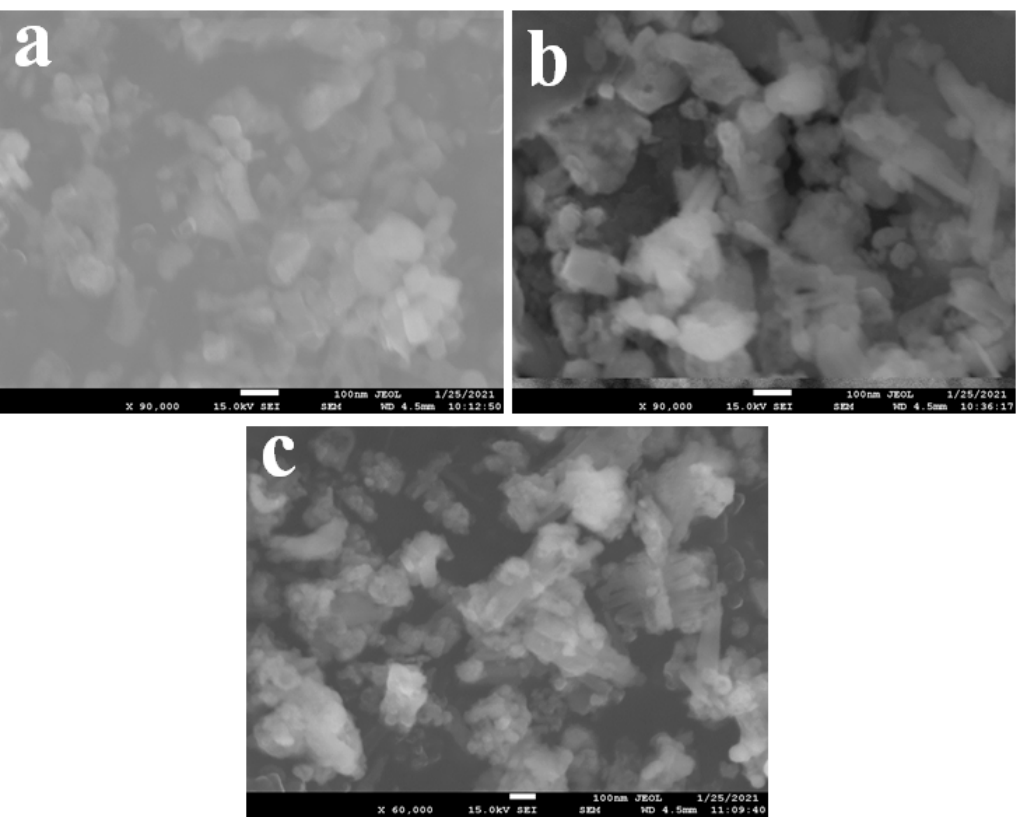
Figure 1. FESEM analysis: ( a ) pure SrSnO 3 , ( b ) Chitosan/SrSnO 3 , and ( c ) Ag-decorated Chi- tosan/SrSnO 3 NCs.